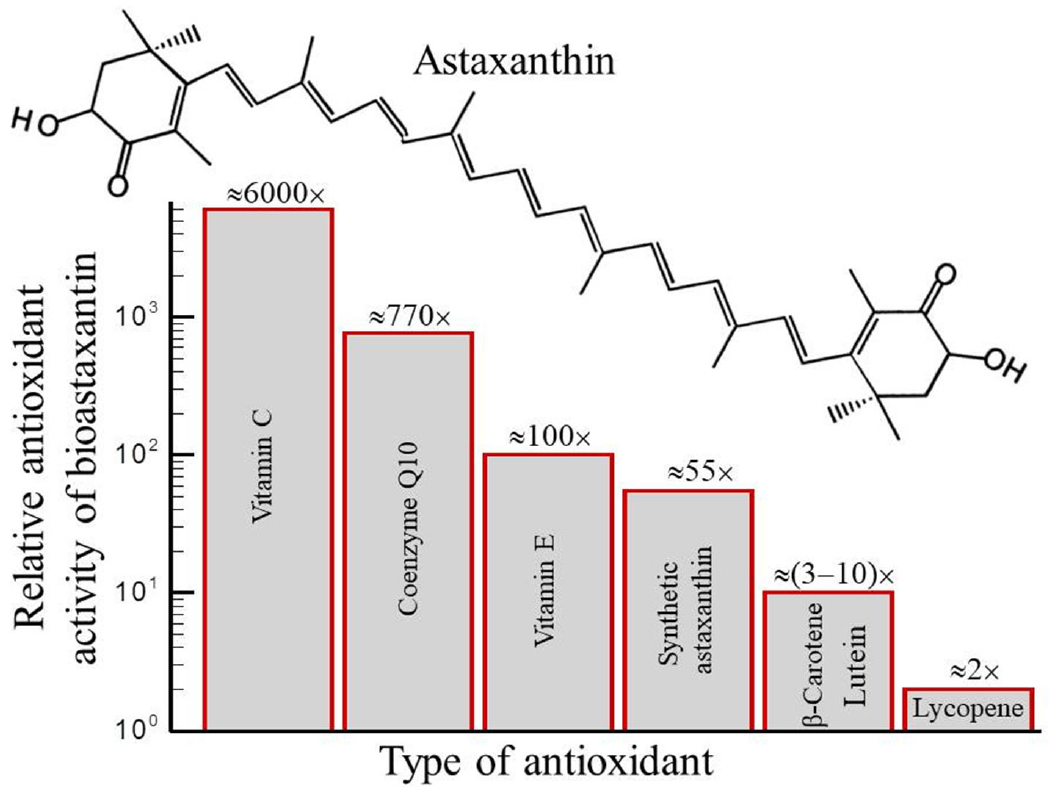
Figure 4. Relative antioxidant activity of natural astaxanthin compared with other antioxidants in the neutralization of destructive reactive oxygen species found in the human body. Based on the data collected in [26,77,150,151].